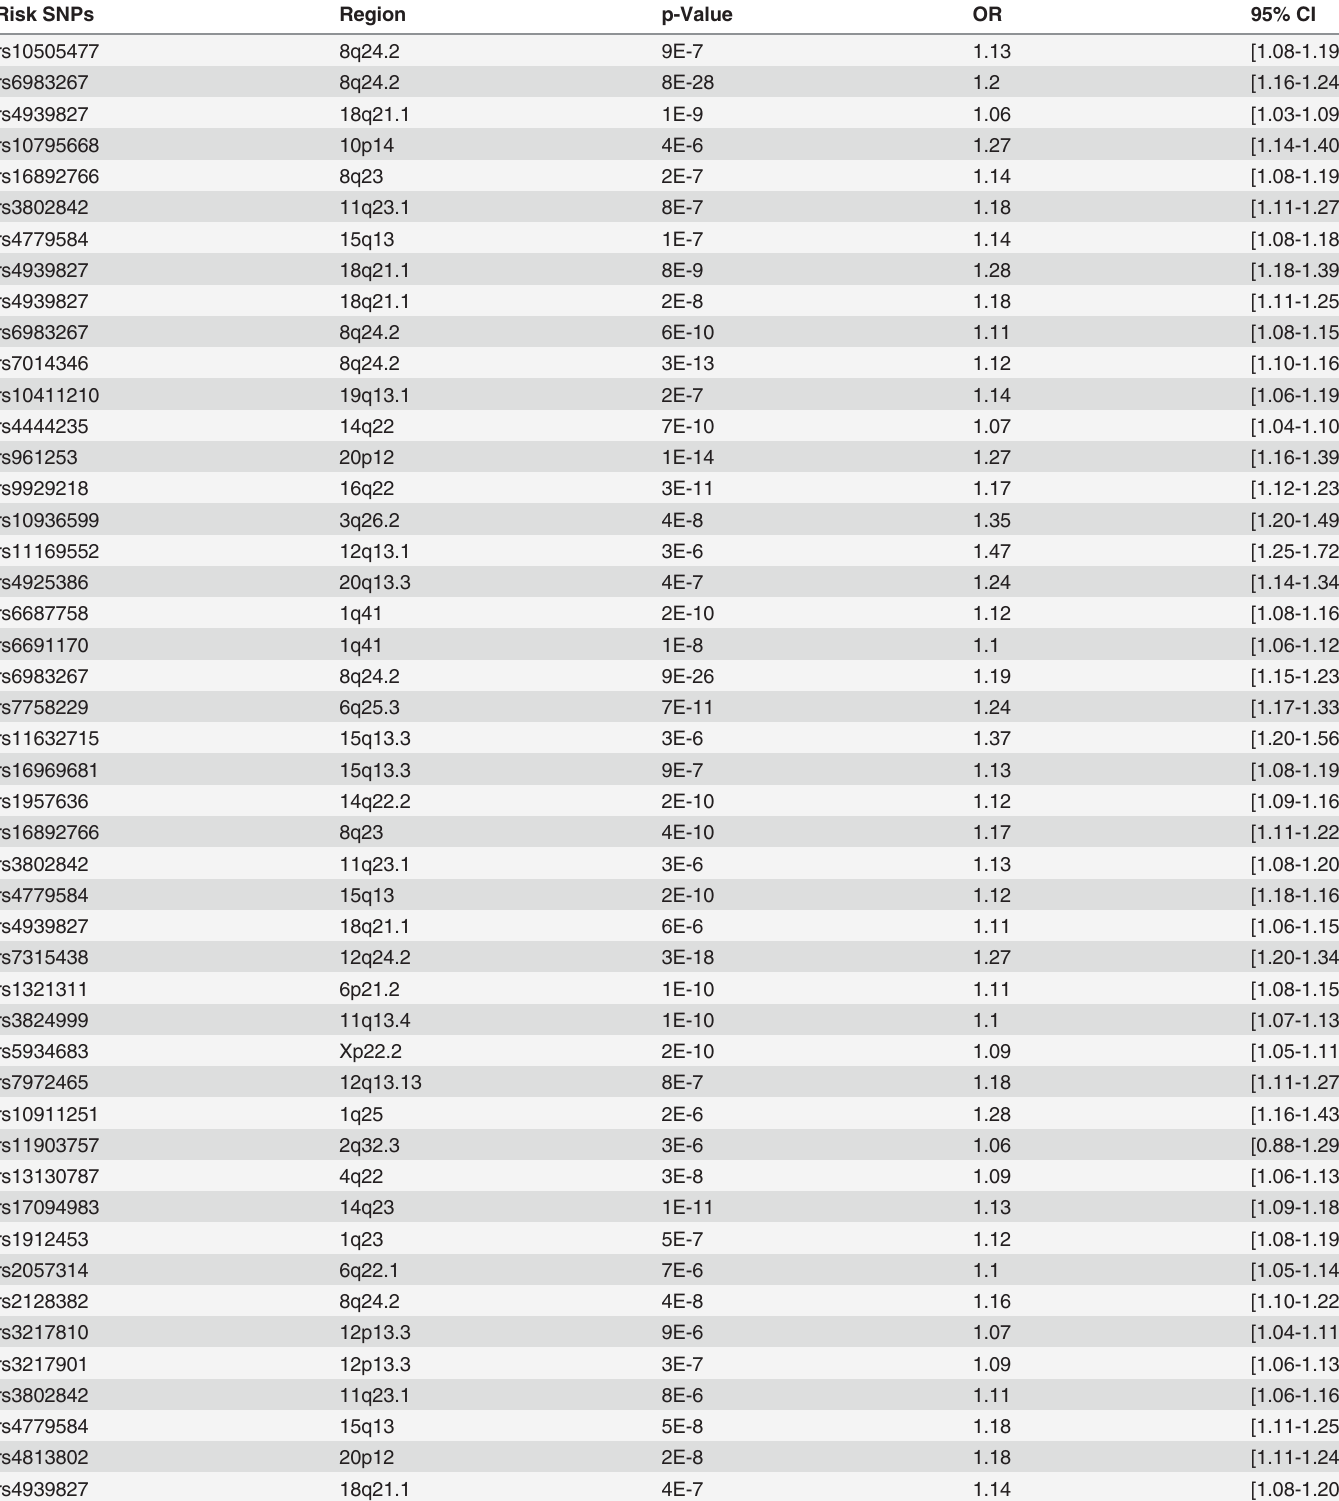
Table 1. Summary of 50 colorectal cancer GWAS risk alleles obtained from National Human Genome Research